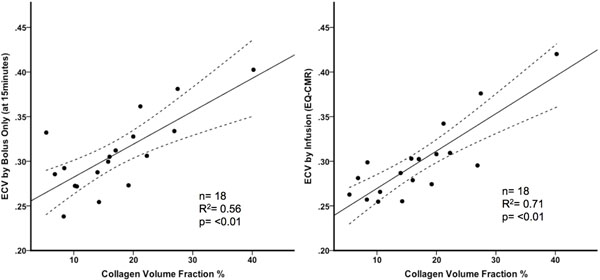
Correlation with histological collagen volume fraction in severe aortic stenosis. Both the bolus only technique (at 15 minutes) and the infusion techniques correlate well with CVF but the r2 value is higher with the infusion technique (0.56 vs 0.71).